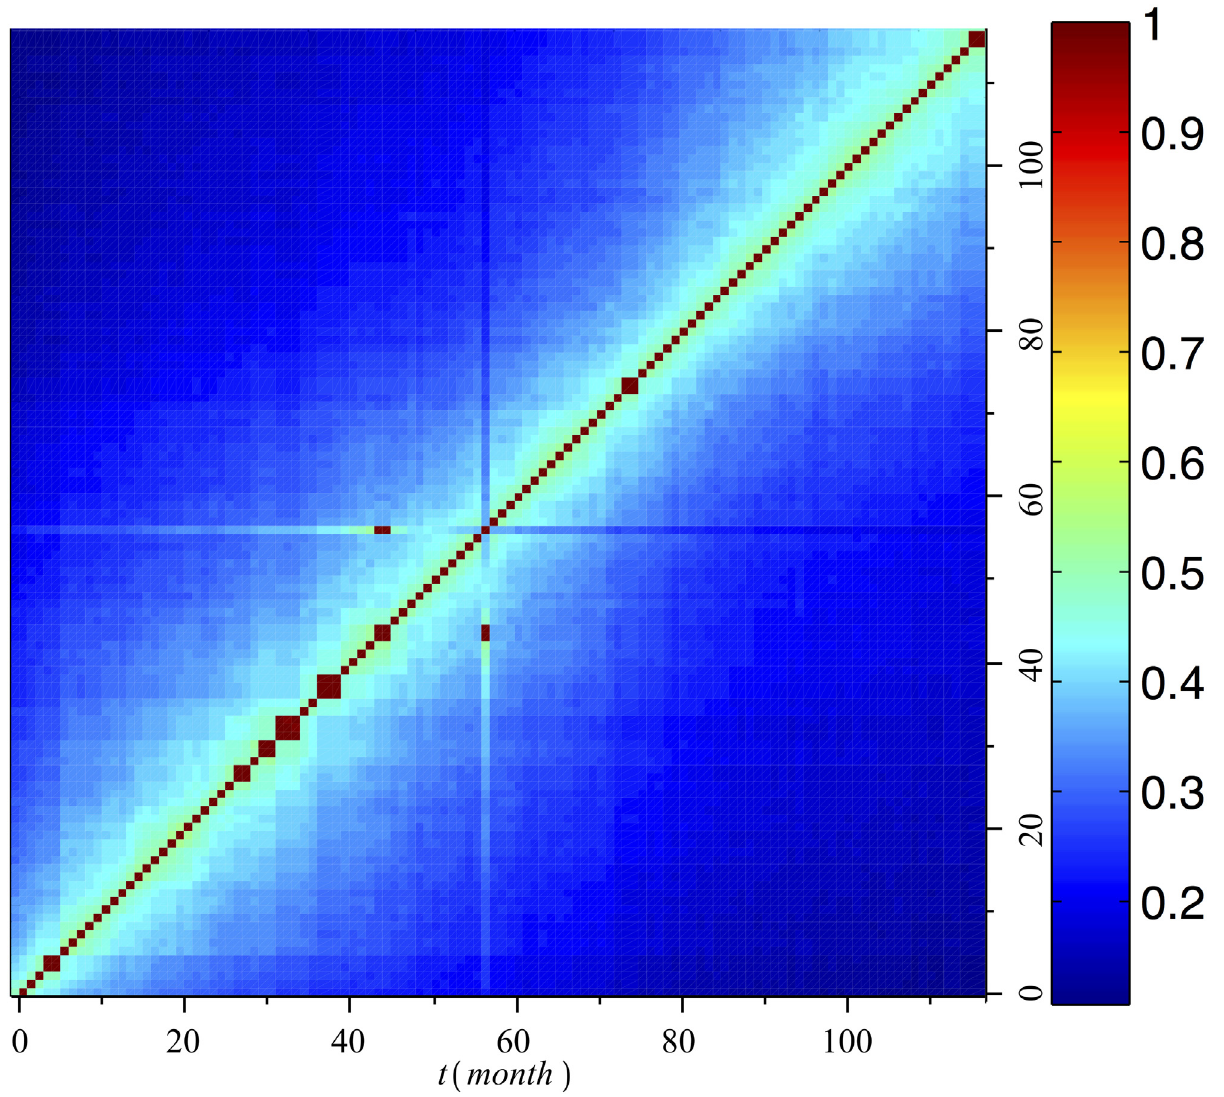
Fig 7. Topological overlap between every graph in the time series and every other graph in the time